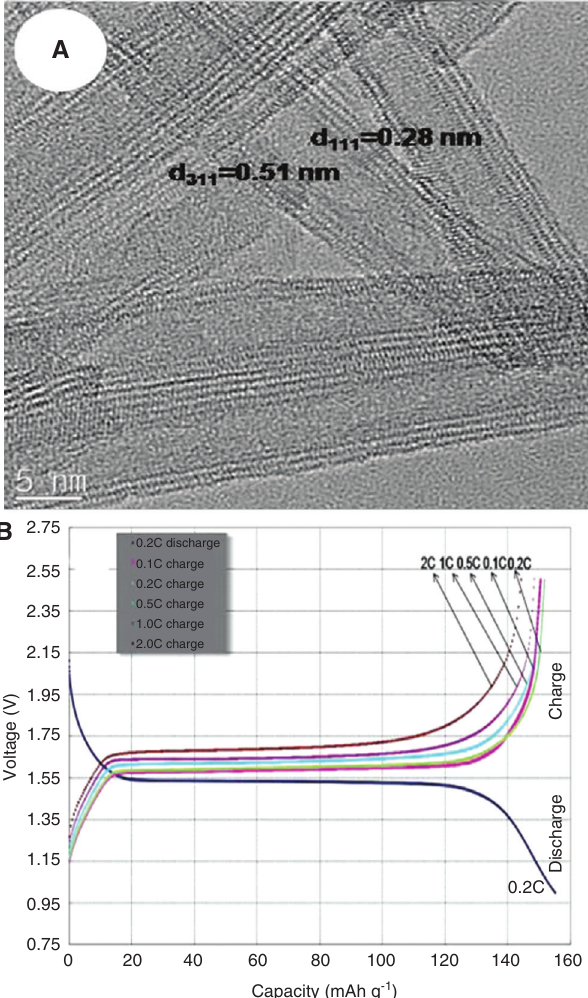
Ti O nanotubes synthesized by 4 5 12 Ti O nanotubes. Reprinted with permission from 4 5 12